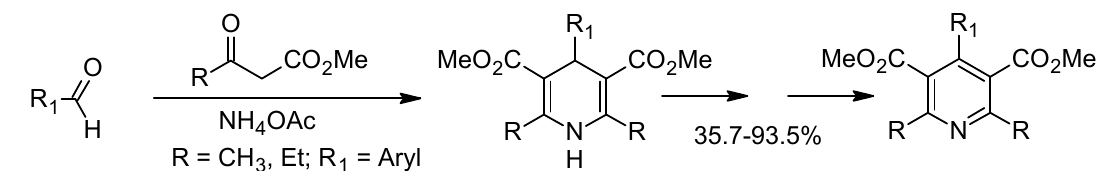
Scheme 8. Catalytic effect of free and immobilized urease, leading to Biginelli and Hantzsch products. DHP: 1,4-dihydropyridine and DHPM: 3,4-dihydropyrimidin-2(1 H )-one.